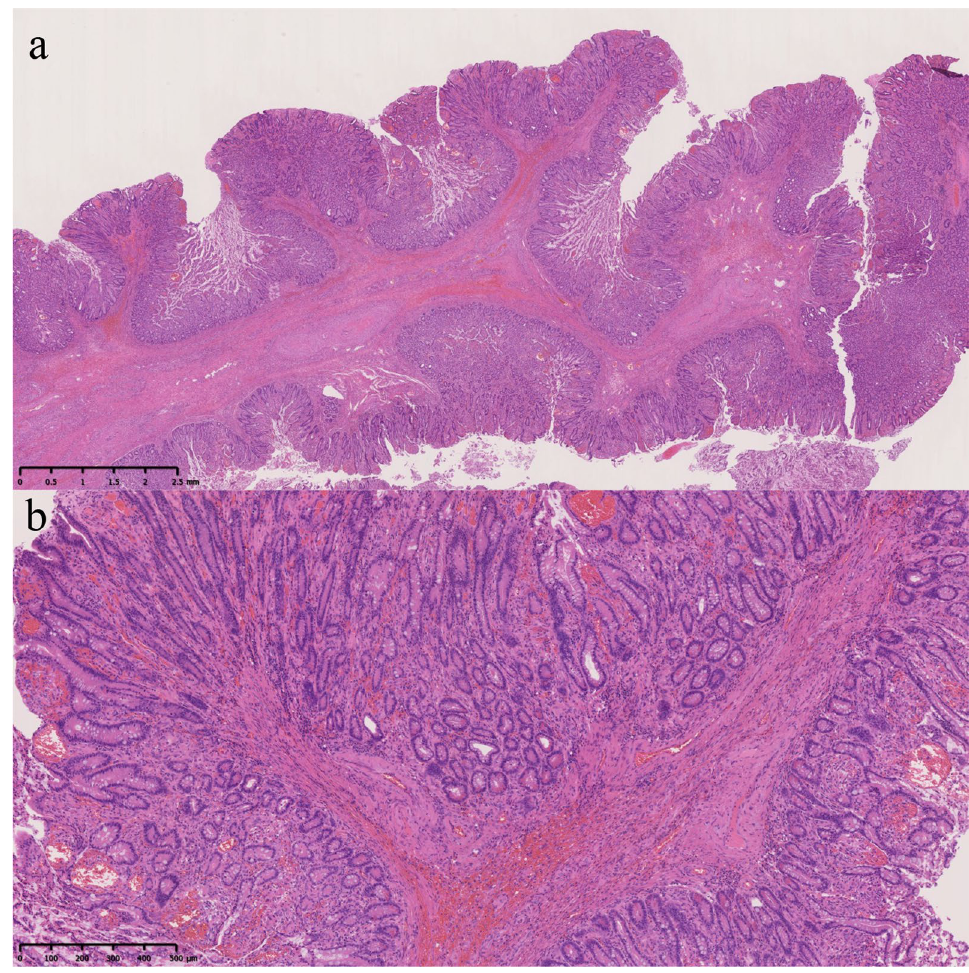
20) showing the polyp covered by normal mucosa and × 100) showing the submucosa containing edematous loose connective tissue ×